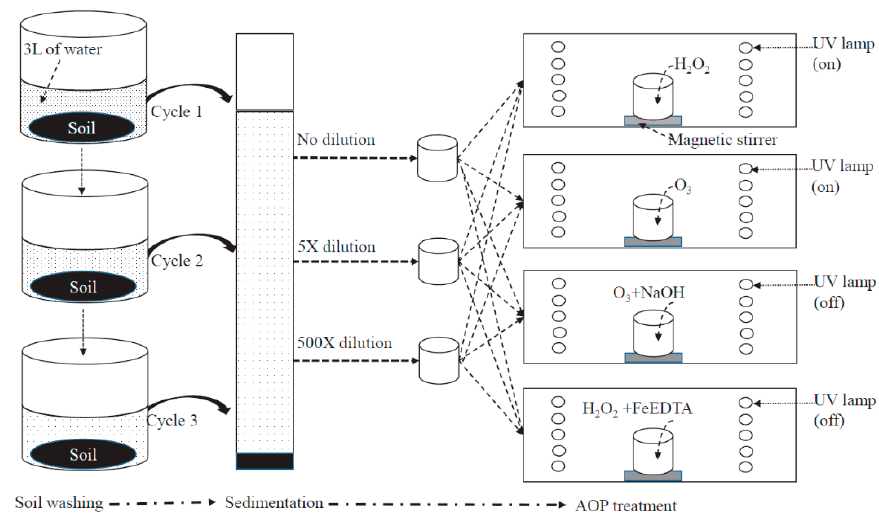
Figure 1. Soil washing-advanced oxidation process (AOP) integration setup.